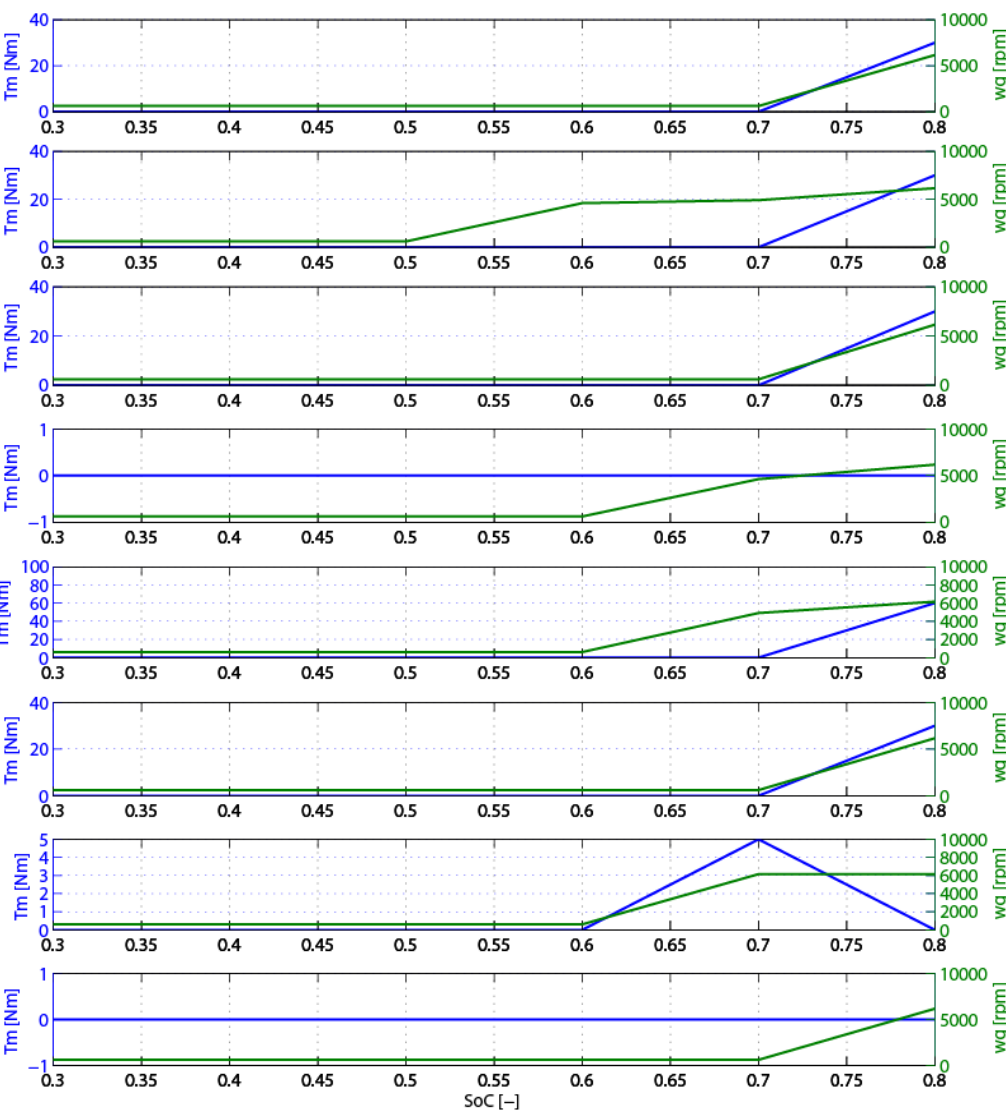
Figure 10. Control policy in the regular